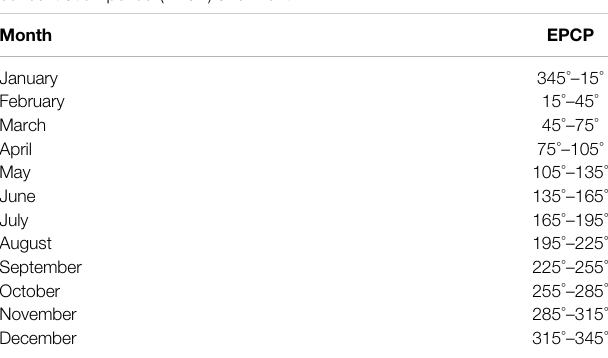
TABLE 1 | Corresponding relationship between extreme precipitation concentration period (EPCP) and